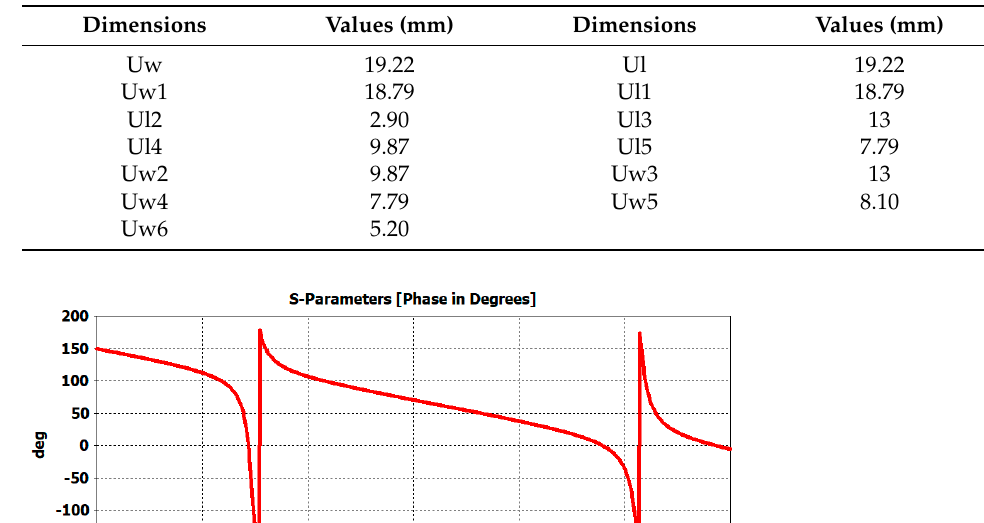
Figure 12. Zero-phase reflection coefficient of the unit cell. Table 3. Dimensions of the unit cell.